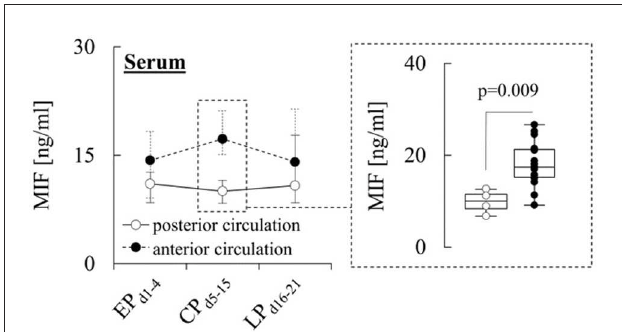
FIGURE2 Serum MIF levels and aneurysm location. Concentration of macrophage migration inhibitory factor (MIF) in serum from patients with aneurysms located in the anterior or posterior circulation during the early (EP d1 − 4 ), critical (CP d5 − 15 ) and late (LP d16 − 21 ) phase after aneurysmal subarachnoid hemorrhage (aSAH). Data are shown as median [25th − 75th percentile] and (for significant differences) as boxplots and individual values (see inset). Statistical significance was assessed using the Mann-Whitney U -test. For details on the exact number of patients per time-point see Supplementary Table 1.